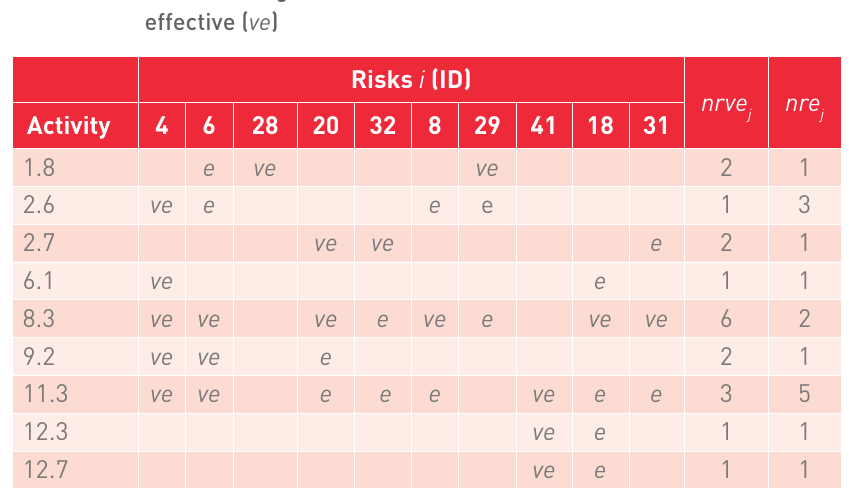
, numeric value of the degree of influence of the risk i over the activity j C ij